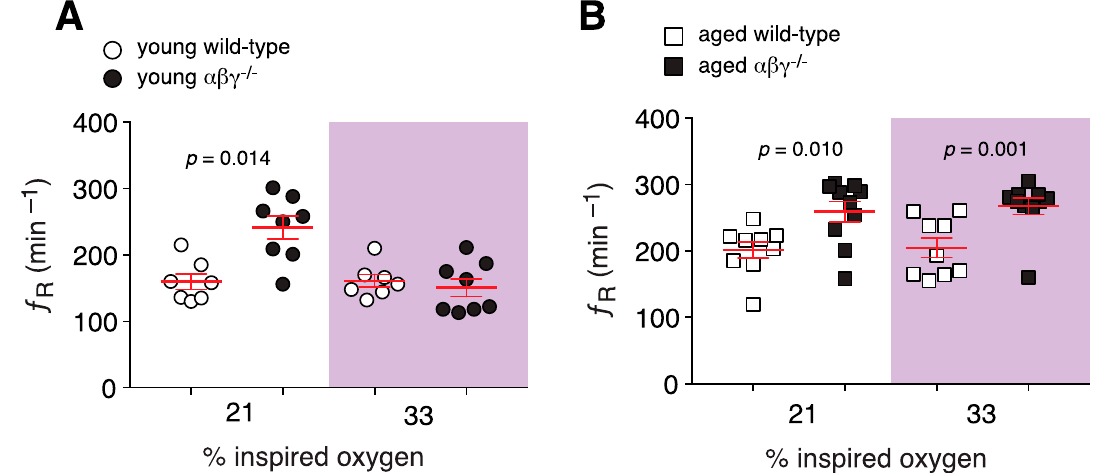
Figure 1. αβγ − / − mice display age-dependent increases in resting breathing frequency in normoxia and hyperoxia. ( A , B ) Population data from whole-body plethysmography measurements showing respiratory rate (ƒ R ) in young ( A ) and aged ( B ) WT and αβγ − / − mice at room air (21% O 2 ) and hyperoxic conditions (33% O 2 ). p —Mann–Whitney U rank test.